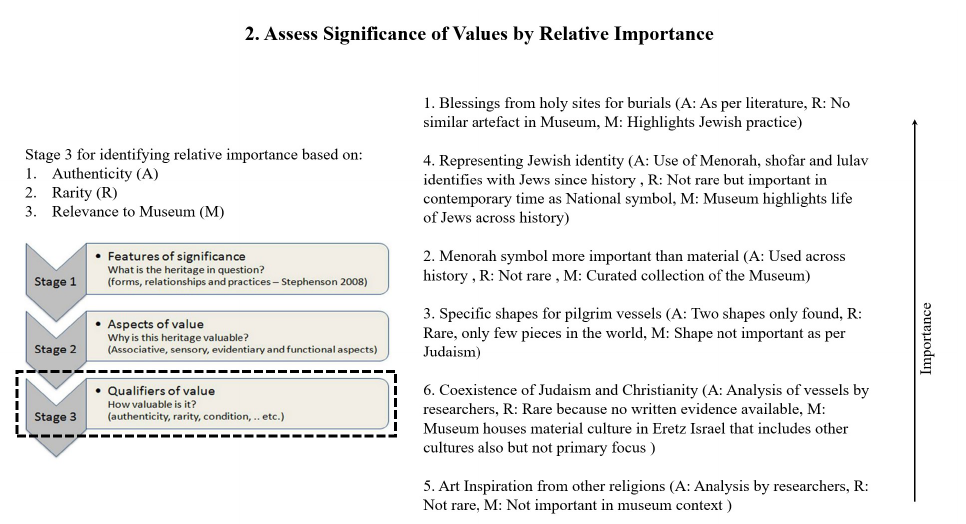
Figure 4. Information relating to the ‘Glass Jar’ artefact is rearranged based on our understanding of its significance based on the Authenticity (A) of the heritage information, the Rarity (R) of the artefact itself and the relevance of the artefact to the Museum context (M). The numbering is kept the same as in Figure 3 to highlight the changes created by this rearrangement.